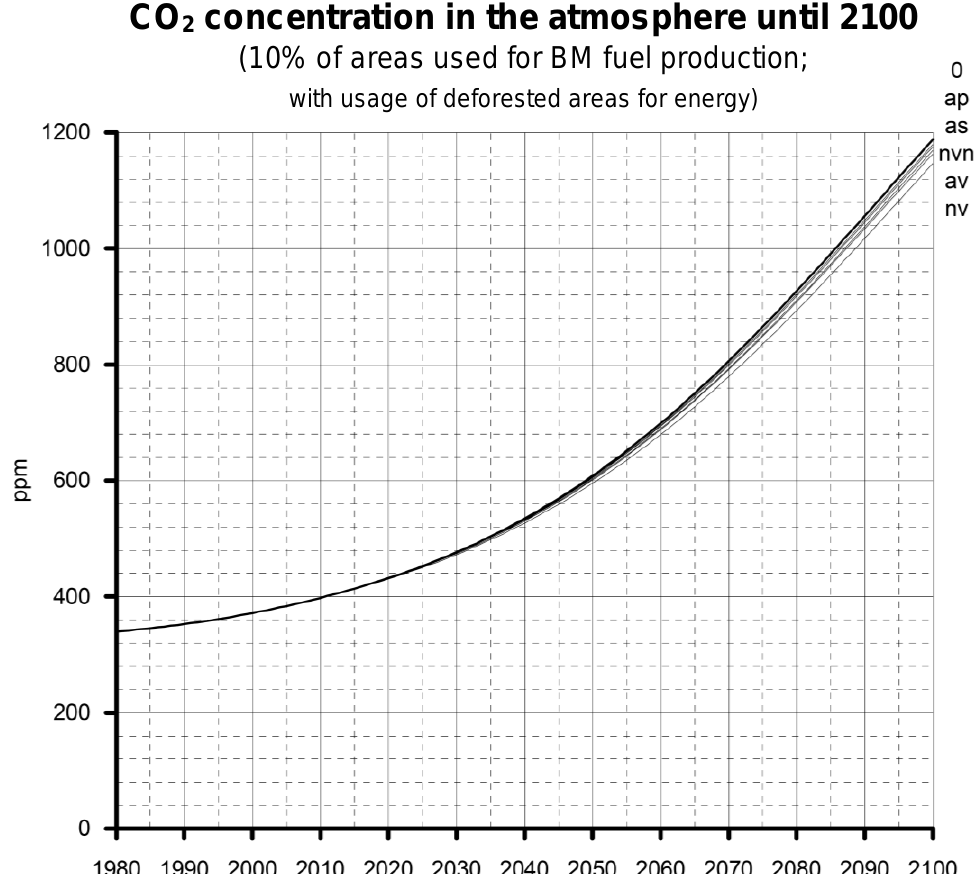
Figure 3. In a “+3%/a” CO 2 emission growth scenario, when dedicating 0.1% of areas for biomass production, all five described types of biomass scenarios ( with combustion of standing biomass on possibly deforested areas) show only a very small effect on the atmospheric CO 2 concentration (from ~1140 to 1180 ppm in 2100).